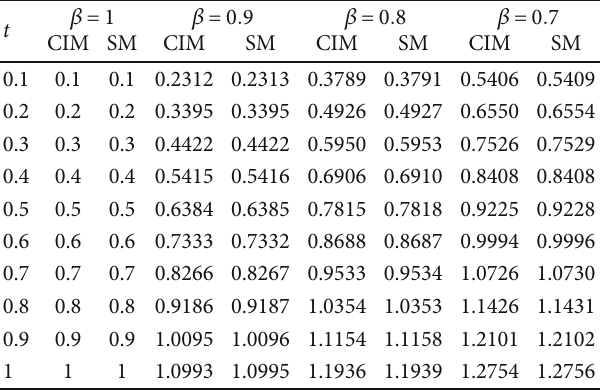
for various values of α 2